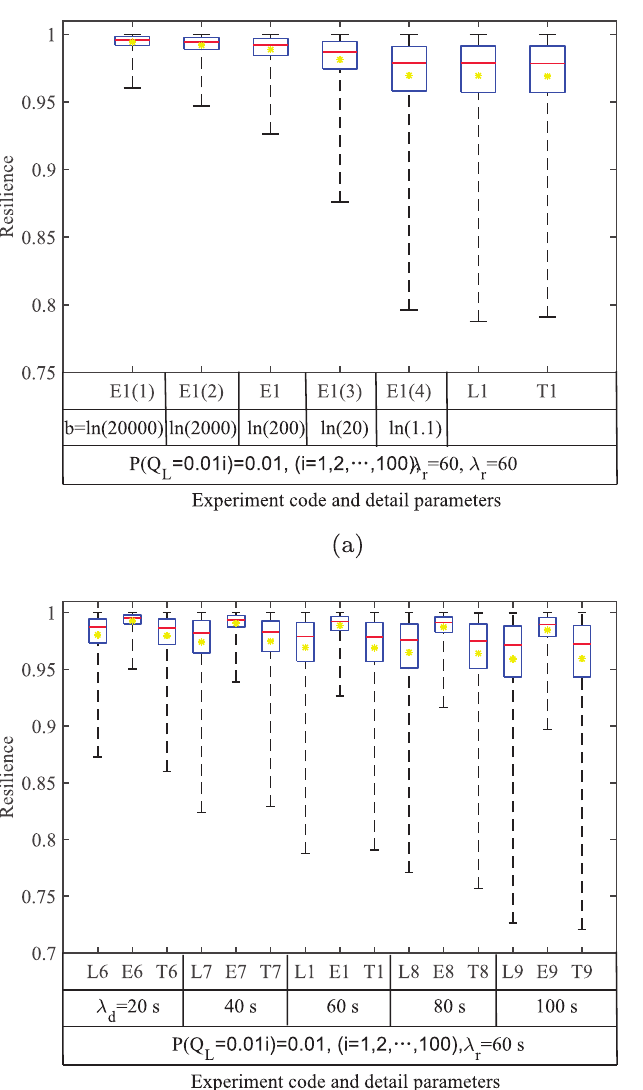
Fig 5. Sample box plots of experiments in Tables 4 and 5. a) effect of performance process functions; b) effect of T represent the mean resilience ℝ and lower 25% percentiles ℝ